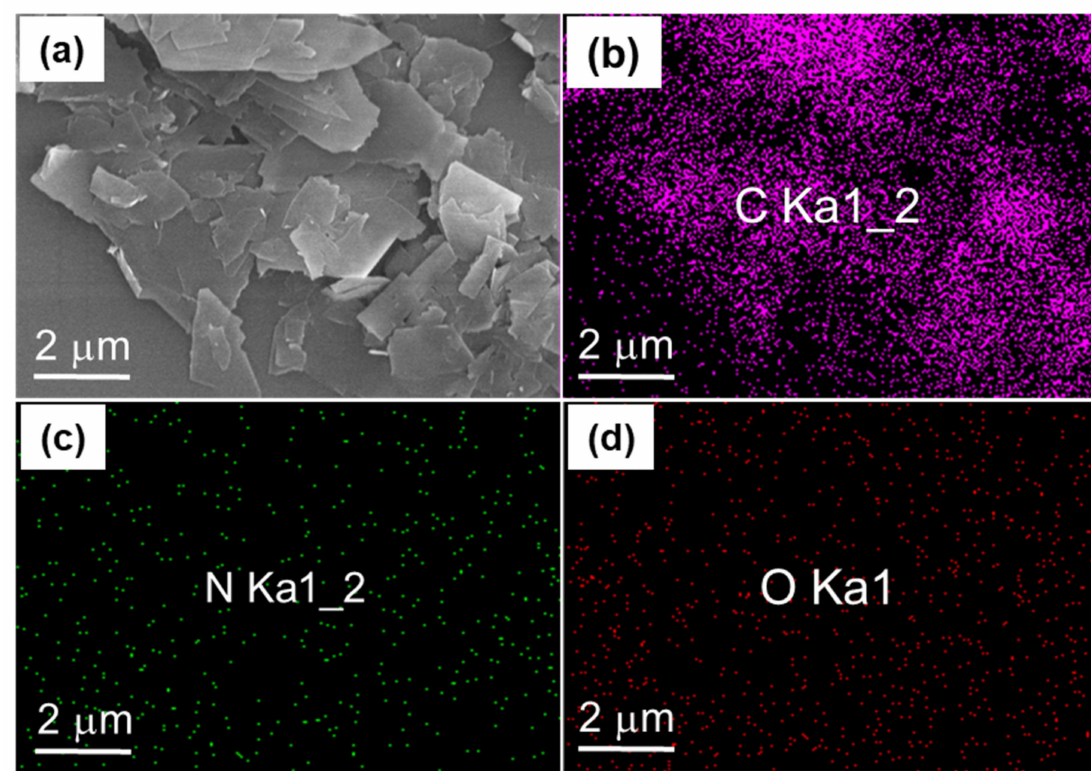
Figure 2. FESEM image of GPNVP composite ( a ) and the corresponding elemental mappings for ( b ) carbon, ( c ) nitrogen, and ( d ) oxygen.